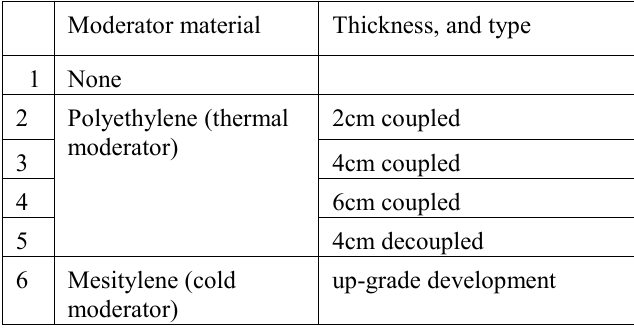
Fig.2 Schematic view of the neutron measurement with 115 In(n,n’) 115m In reaction at RANS [2]